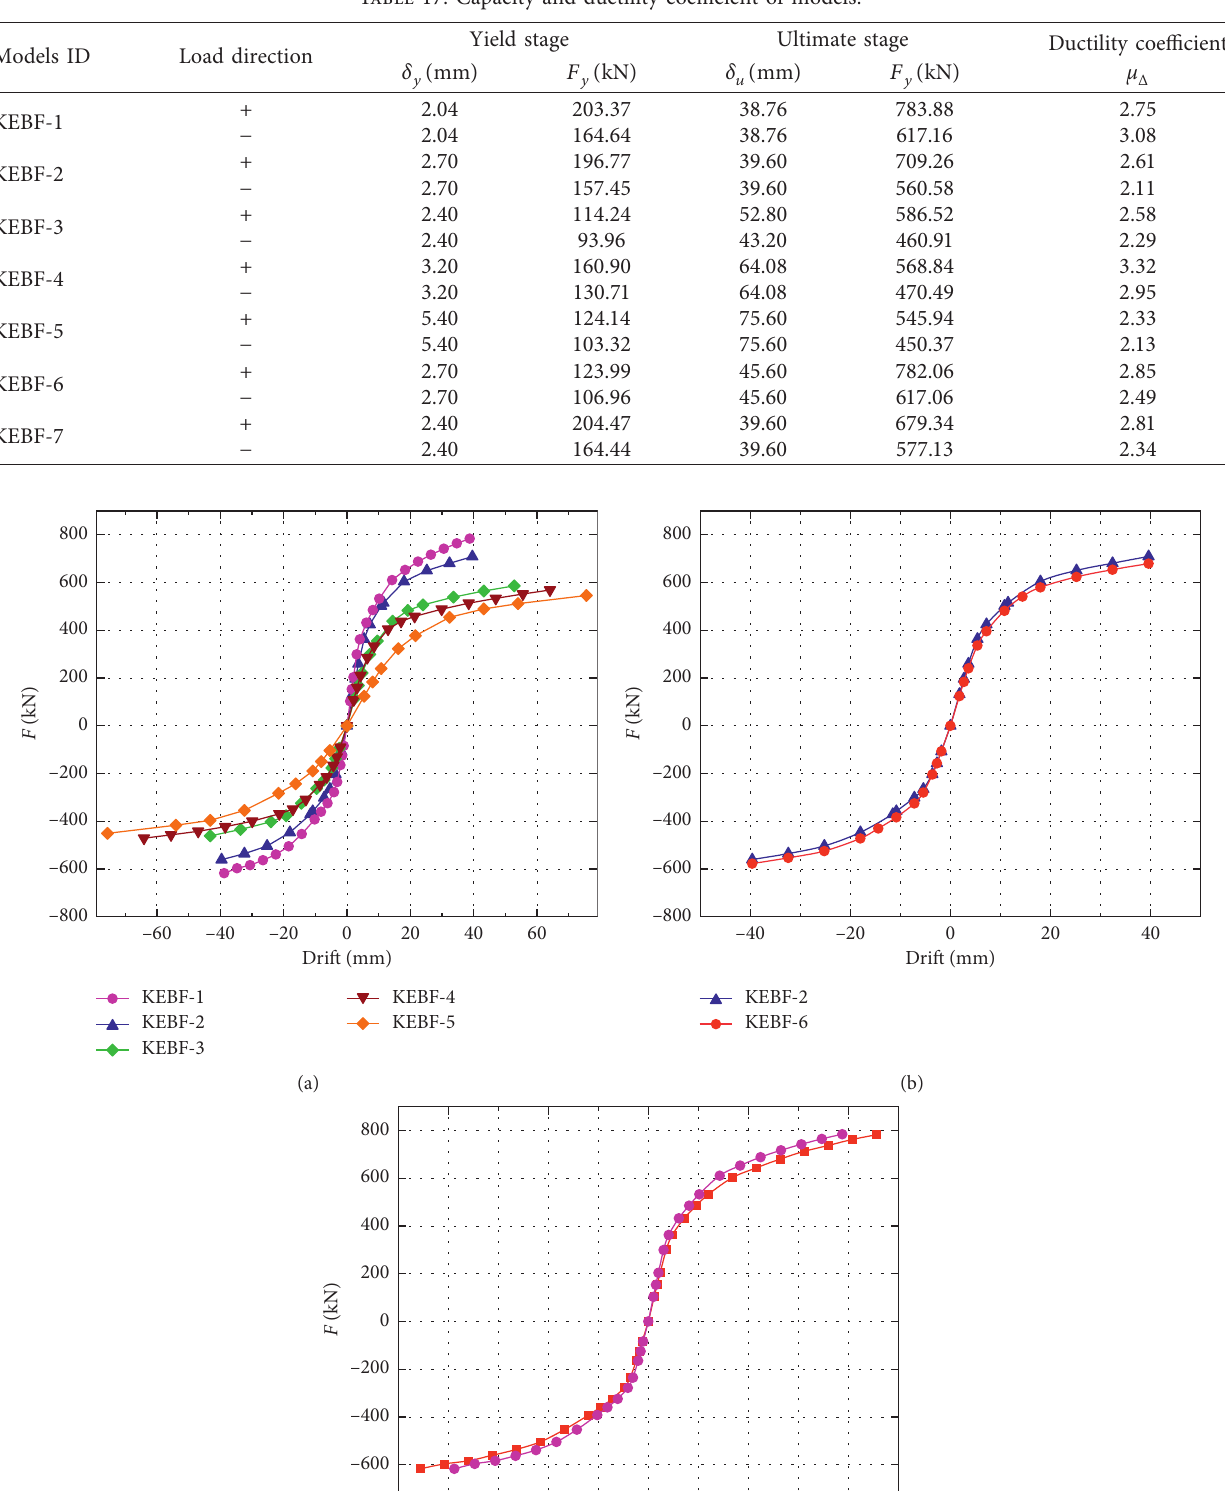
Table 17: Capacity and ductility coefficient of models.